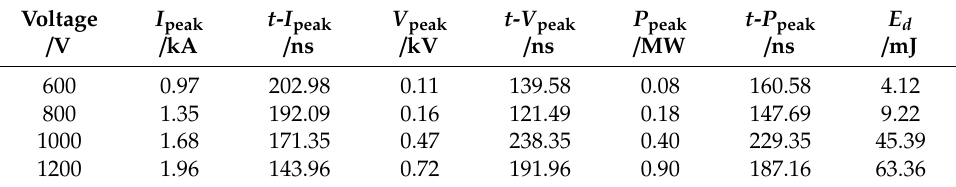
Figure 7. Electric explosion curves of the McEFI at different capacitor voltages ( a ) 600 V/0.22 μF; ( b ) 800 V/0.22 μF; ( c ) 1000 V/0.22 μF; and ( d ) 1200 V/0.22 μF.